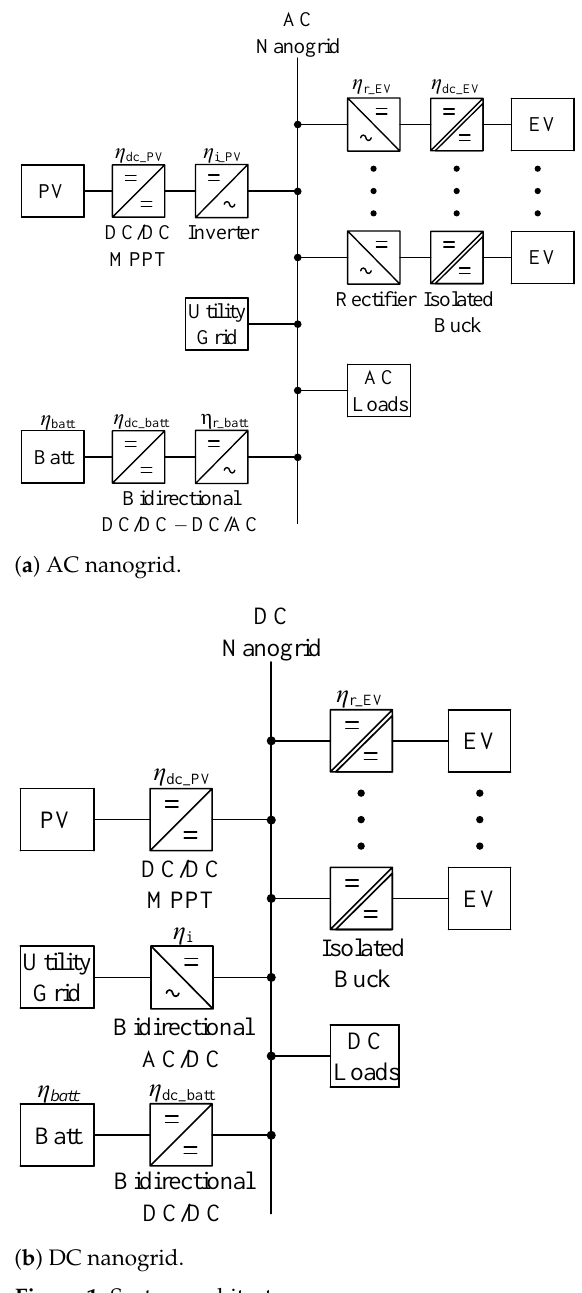
Figure 1. System